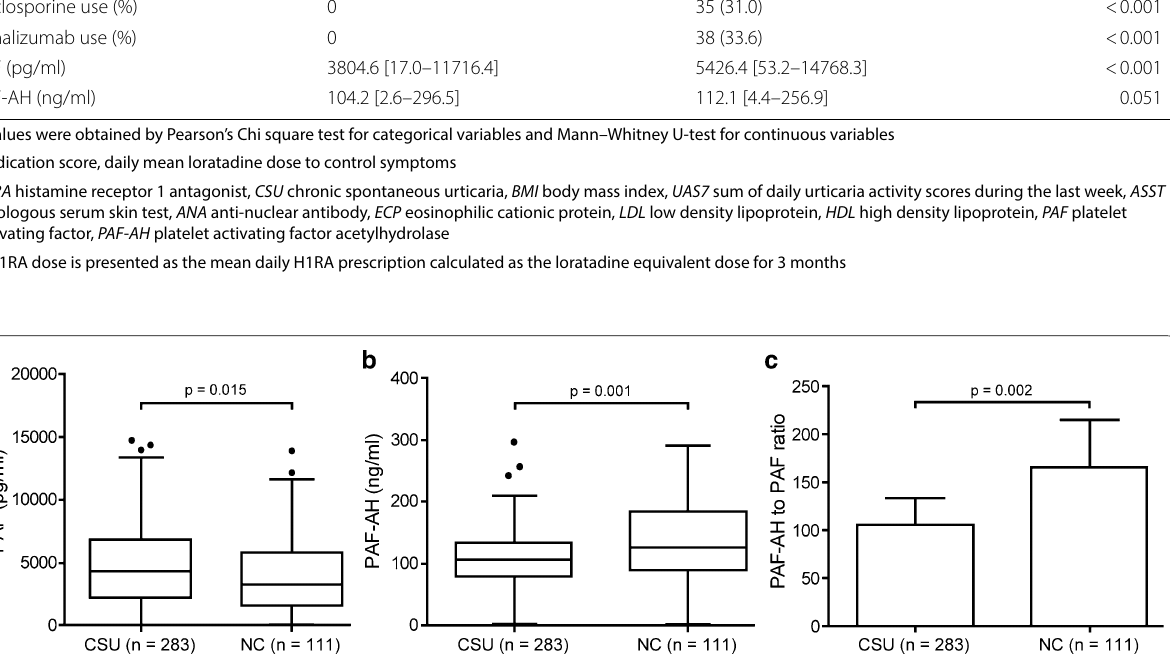
Fig. 1 Serum levels of PAF ( a ) and PAF‑AH ( b ) and PAF‑AH to PAF ratio ( c ) in patients with CSU and NCs. PAF platelet activating factor, PAF ‑ AH platelet activating factor acetylhydrolase, CSU chronic spontaneous urticaria, NC healthy normal control. p values were calculated by Mann–Whitney